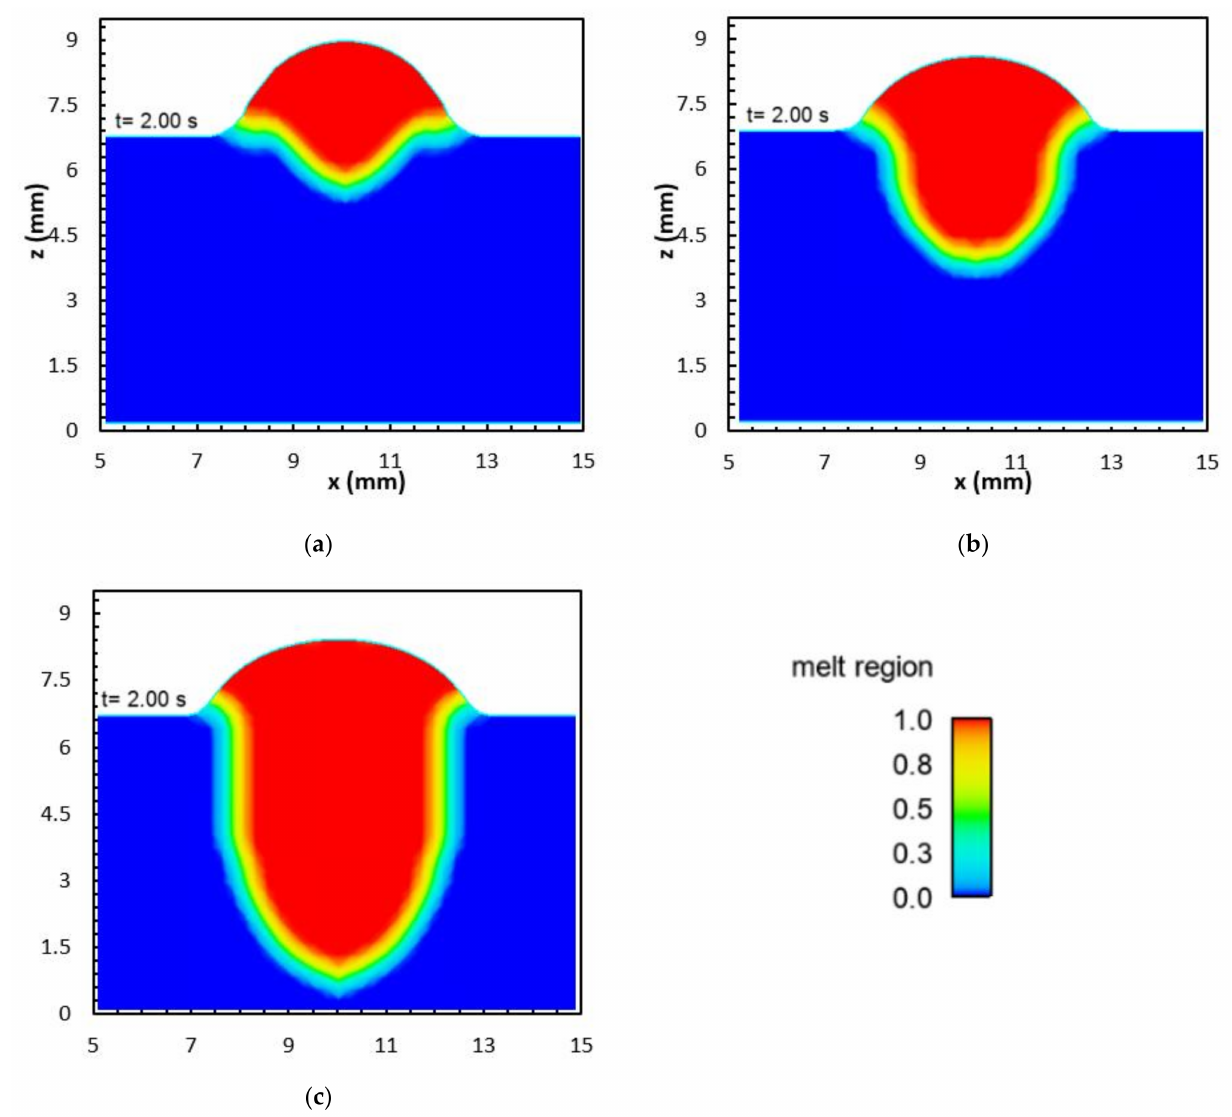
Figure 9. Melt pool dimension using different heat fluxes: q ( a ), 3q ( b ), and 6q ( c ). Case 2: Same input heat flux with different surface